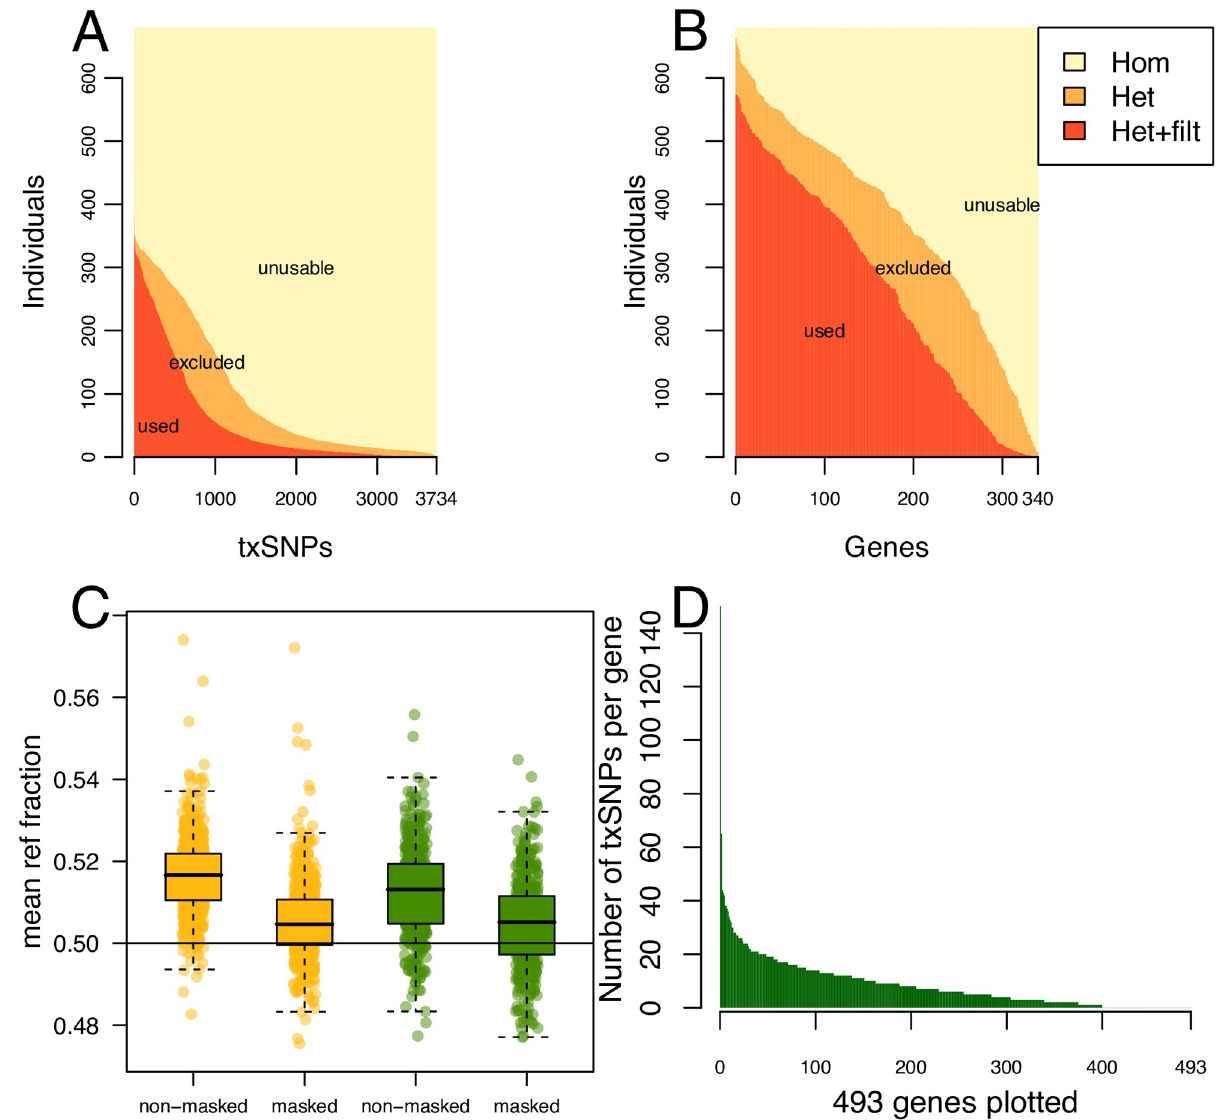
Fig 2. Filtration and mapping bias considerations in analysis pipeline. (A) Shows the least amount of individuals (Y-axis) for a given amount of txSNPs (X-axis) at different condition levels, namely Het , i.e. count of heterozygous SNPs, Het+filt , i.e. the count of heterozygous SNPs that pass QC filtration, and Hom , i.e. the remaining SNPs, which are homozygous. (B) Similar, but instead with an X-axis showing gene-count for which at least one txSNP fulfills the condition level. In other words, the number analyzable individuals for a given amount of the genes of interest. (C) The fraction of reference-allele containing reads measured over all txSNPs, dependent on using a masked or a non-masked genome. The horizontal line at 0.5 indicates the expected fraction under the assumption of no mapping bias. Yellow indicates DLPFC tissue, green indicates Hippocampus tissue. (D) Number of txSNPs in the genes of interest with at least one heterozygote sample among the 782 analyzed